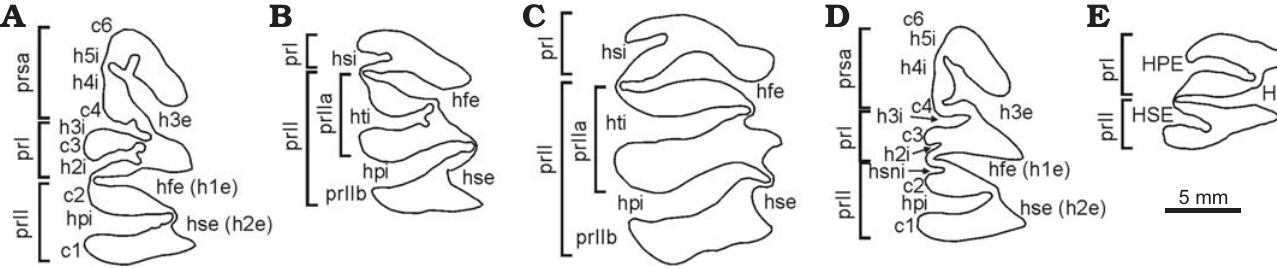
Fig. 2. Dental nomenclature (occlusal view). A – C , E . Cardiatherium calingastaense sp. nov. A . Right p4. B . Right m1. C . Right m3. E . Right M1. D . Cardiatherium patagonicum , right p4. Abbreviations: c, column; he, external fissure (or flexid); HFI, fundamental internal fissure (hypoflexus);